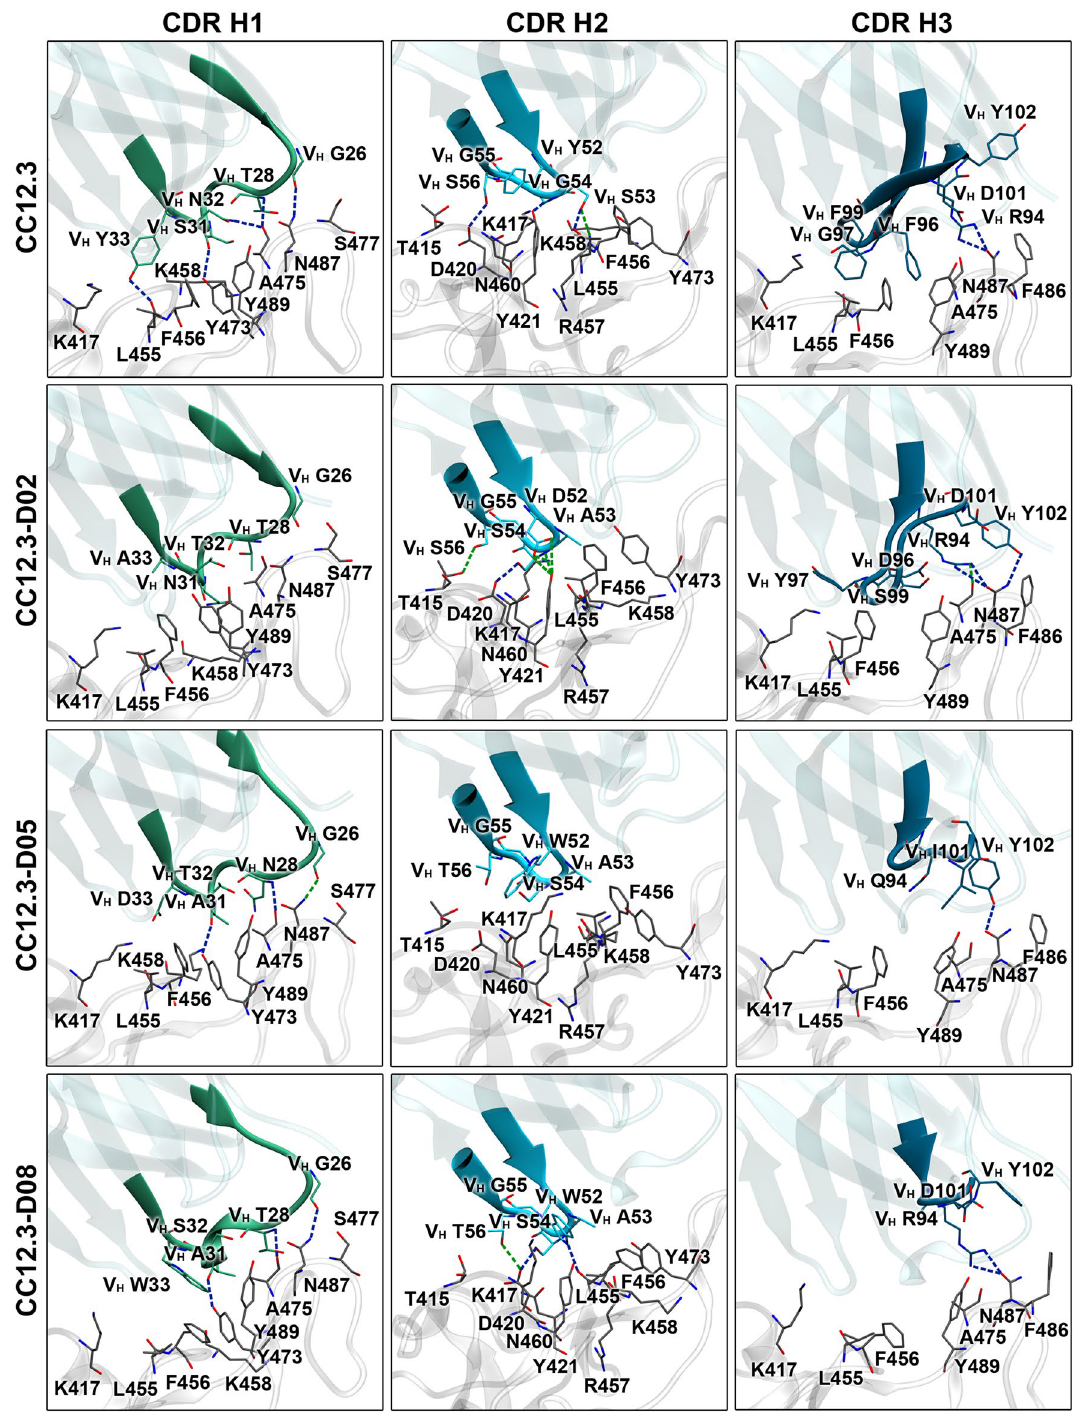
Figure 4. Key binding interactions between SARS-CoV-2-RBD and heavy chains of CC12.3, CC12.3-D02, CC12.3-D05, and CC12.3-D08. Strong and medium hydrogen bonds are shown in blue and green dashed lines,